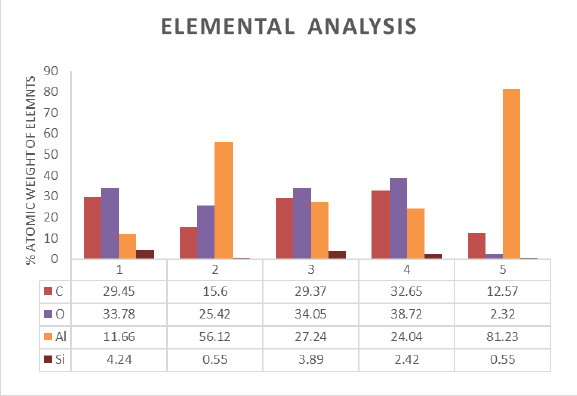
Figure 12: Percentage atomic weight of elements in oxide layer for selected samples.